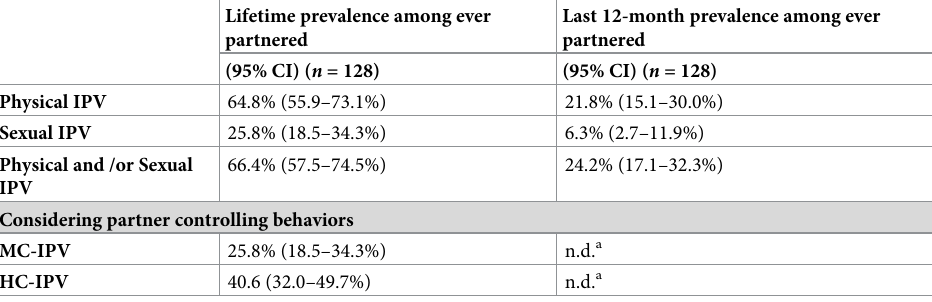
Table 2. Lifetime and last-12-month prevalence of IPV